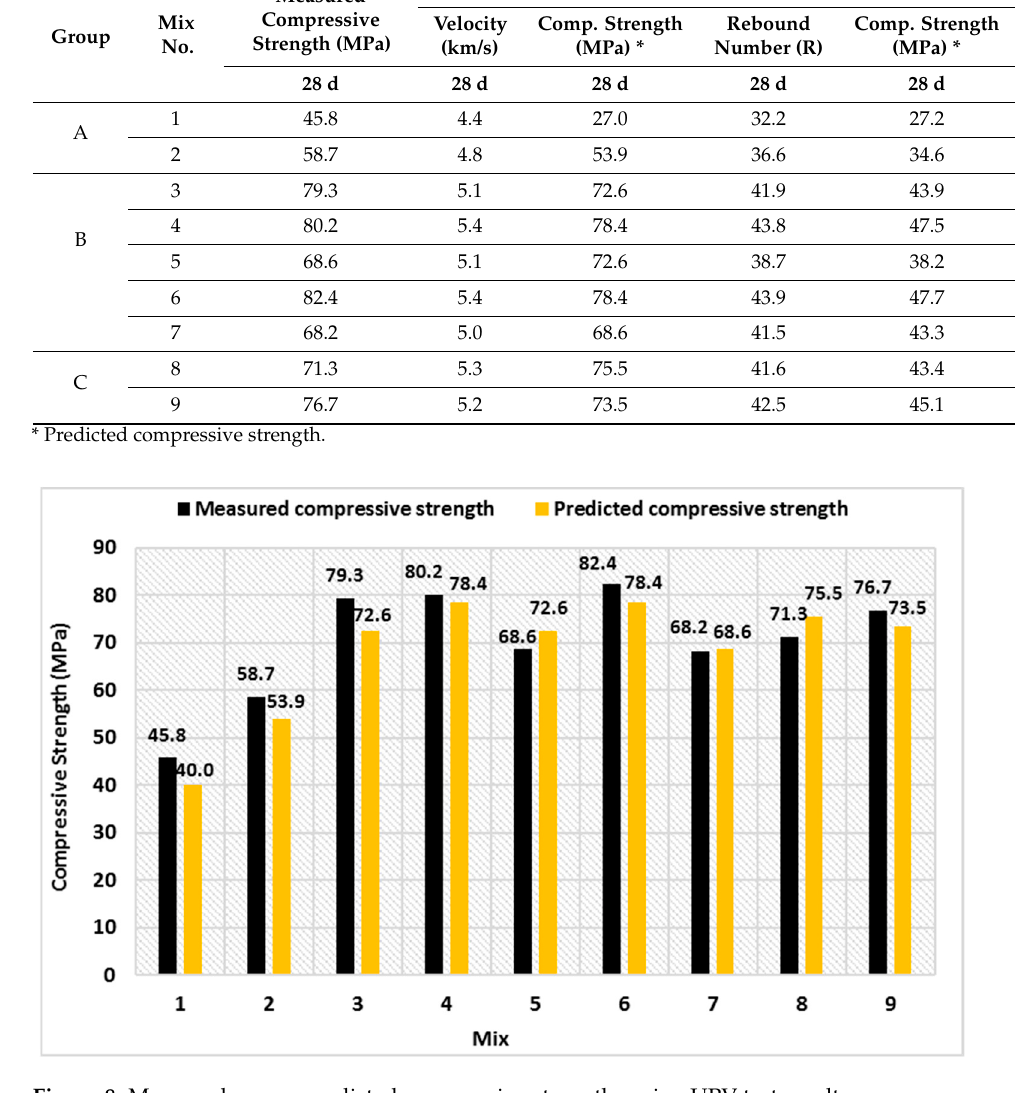
Figure 8. Measured versus predicted compressive strengths using UPV test results.